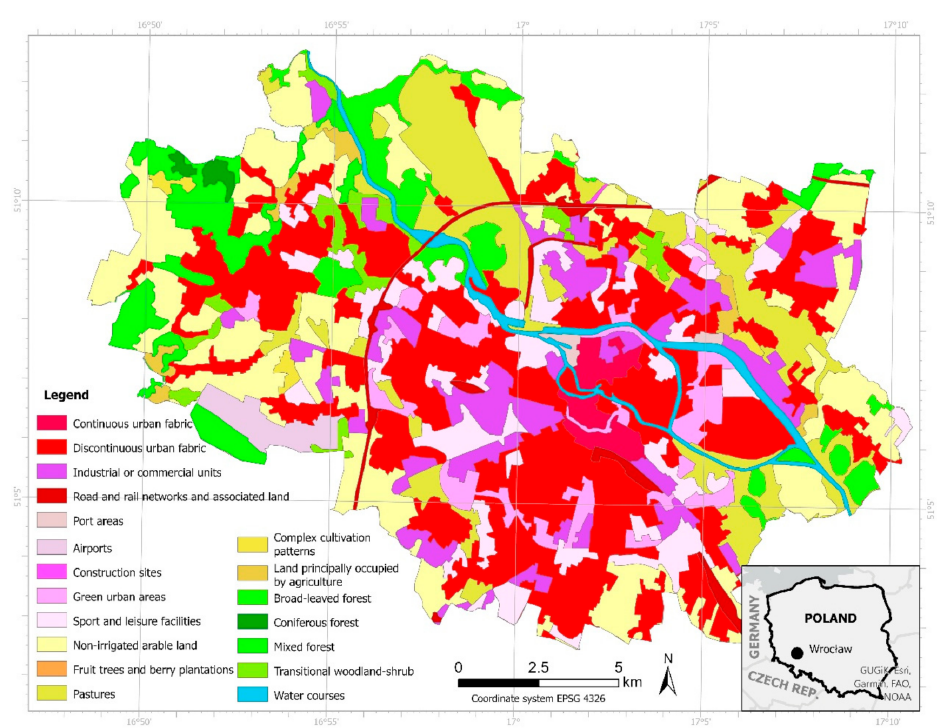
Figure 1. Land use in Wroclaw based on the Corine Land Cover classification (2018).